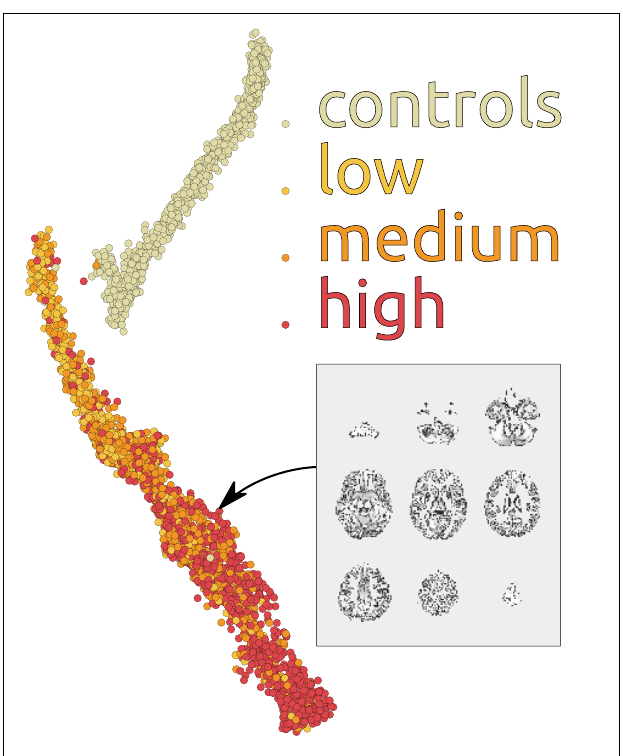
FIGURE 8 | Patients and controls group separation map with additional unsupervised spectral decomposition of sMRI scans by disease severity. The map represents 3500